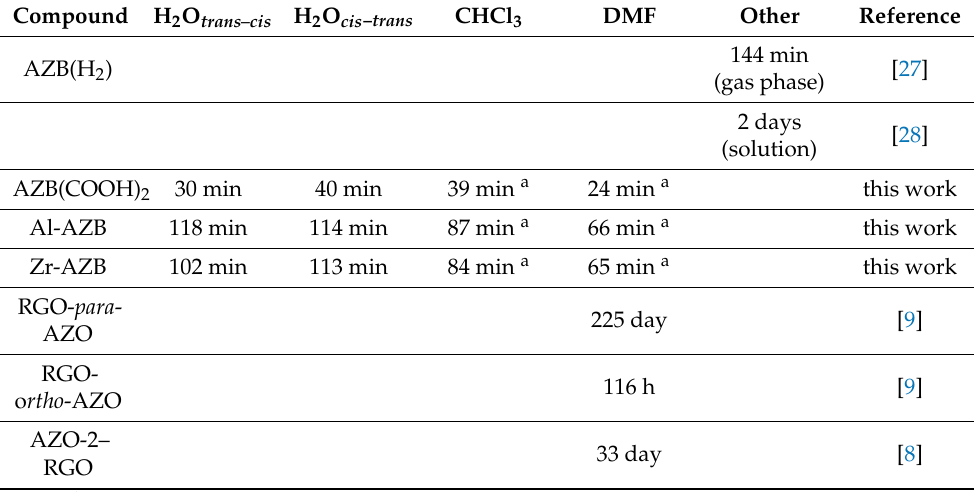
Table 2. Half-life (t 1/2 ) obtained for the indicated compounds in different solvents in this study and the